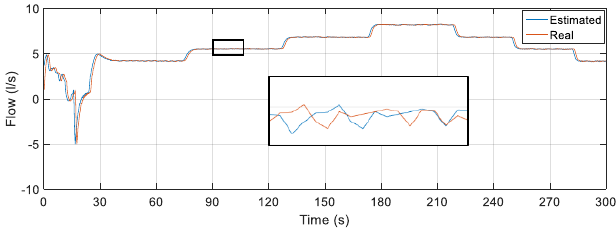
Figure 18. Estimated and real flow: Testing B.